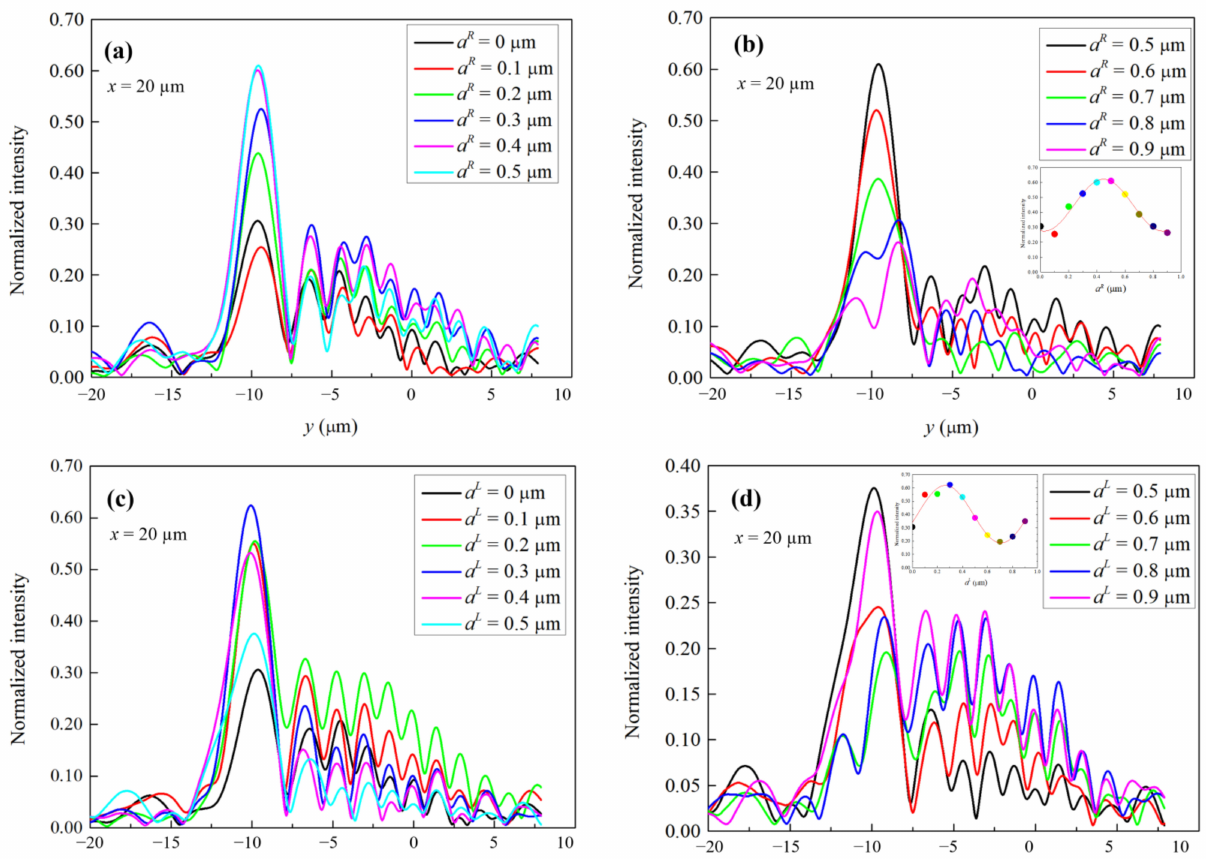
Figure 5. Transverse electric field intensity distributions at x = 20 µ m with different ( a , b ) a R and ( c , d ) a L in the x – y plane. The insets in ( b , d ) are electric field intensity values at point A for various values.